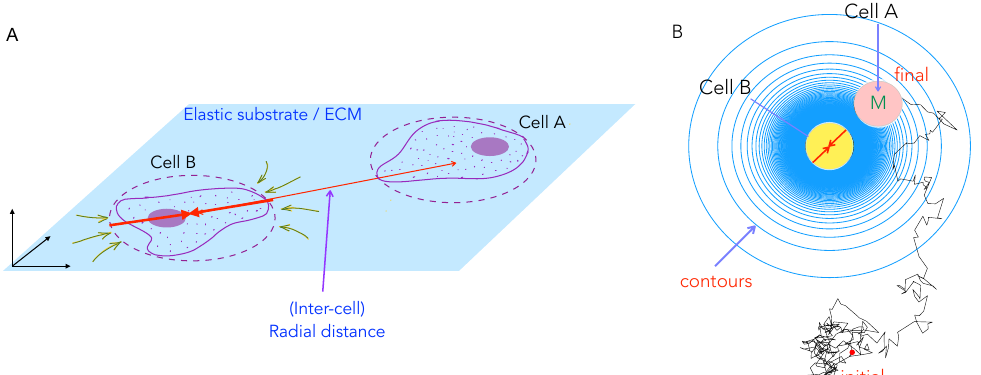
Figure 2. Schematic of the cell–cell mechanical interactions model: ( A ) Two cells A and B cultured on the surface of thick elastic substrate can sense each other and interact at long range (when the inter-cell distance r is longer than typical cell sizes, depicted here by dashed red circles) through mechanical deformations of the underlying substrate; here the contractile stresses set up in the substrate yield deformations as indicated by green arrows. The cells are restricted to move on the surface of the substrate. ( B ) We study with our computational model how a motile cell (M, Cell A, pink) moves in the presence of a fixed central cell (Cell B, yellow). This two cell system on a substrate (schematic shown as a top view) also mimics scenarios where a motile cell may encounter an elastic impurity or obstacle on the medium. Shown in blue circles are contours of constant elastic potential (in simplified form) that determine the inter-cell elastic force that is experienced by the motile cell B as a result of the elastic deformations of the medium by both cells A and B. Also shown (in black) is a representative simulated trajectory of the motile cell which starts outside the area of influence of the stationary